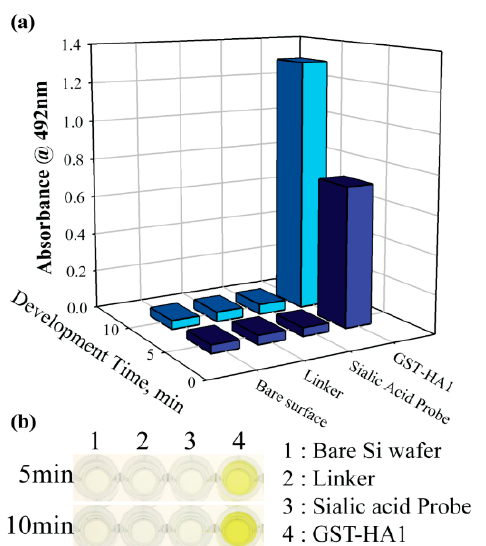
Figure 7. ELISA of functionalized Si wafer. ( a ) Absorbance was measured at 492 nm after sequential functionalization of Si wafer; bare surface, surface immobilized with linker (APTES and GA), surface functionalized with CMP ‐ NANA, and addition of HA1 domain to the surface of functionalized CMP ‐ NANA. ( b ) Color changes of terminated reaction with 2 N H 2 SO 4 in 96 ‐ well plate.